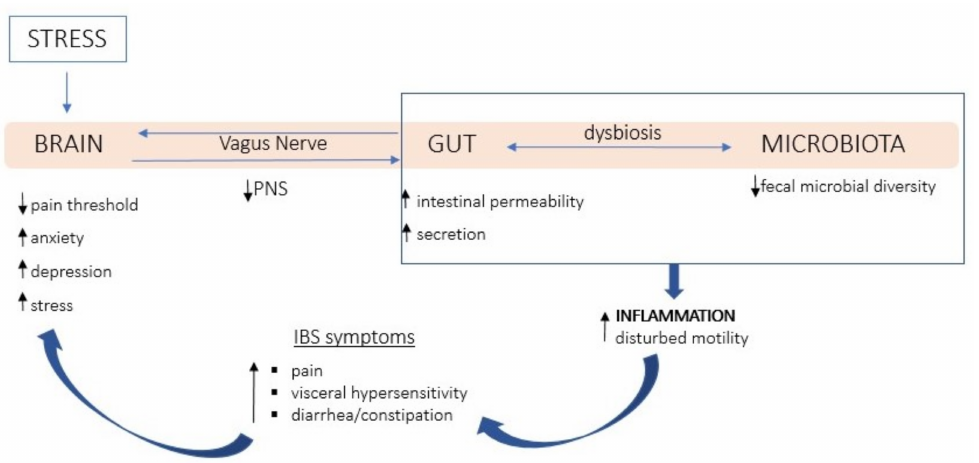
Figure 1. Schema the relationship between disturbed autonomic balance and IBS symptoms. Note: Permanent stress and negative emotions inhibit the vagus nerve function, which manifests itself in hypoactivity of the PNS. Under the stress, the homeostasis of the intestinal epithelium is disturbed, and the microbiota composition is modified, e.g., reduction of fecal microbial diversity, which may lead to dysbiosis. Impaired secretory and barrier functions of the intestinal mucosa are characterized by increased intestinal permeability and secretion, which contribute to the development of intestinal inflammation and disturbances in intestinal motility. Inflammation causes pain, problems with defecation (diarrhea/constipation), and the visceral hypersensitivity increases. These symptoms affect neurophysiological changes (including lowering the pain threshold) and mental changes (increased anxiety, depression) in the brain, which secondarily generates stress and reduces the anti-inflammatory efficiency of the vagus nerve. This simplified elaboration is based on Bonaz et al., 2018 [11] and Drossman, 2016